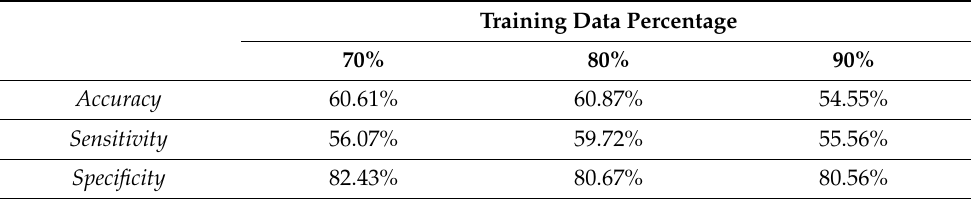
Table 4. Performance measurements of the Quadratic Discriminant Analysis (QDA)